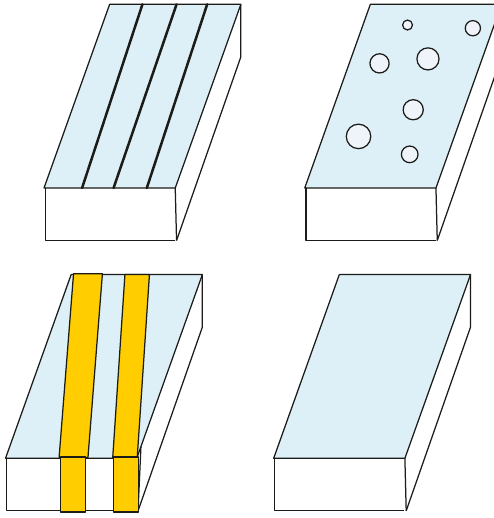
Figure 2: Composites by reinforcement